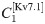
State transition diagram of the Markov model for the Kv7.1 channel.
C1[Kv7.1]–C2[Kv7.1] are the closed states, O1[Kv7.1]–O2[Kv7.1] are the open states and I[Kv7.1] the inactivation state. α1[Kv7.1], β1[Kv7.1], α2[Kv7.1], β2[Kv7.1], λ[Kv7.1], μ[Kv7.1], δ[Kv7.1], and ϵ[Kv7.1] denote transition rates between the states.